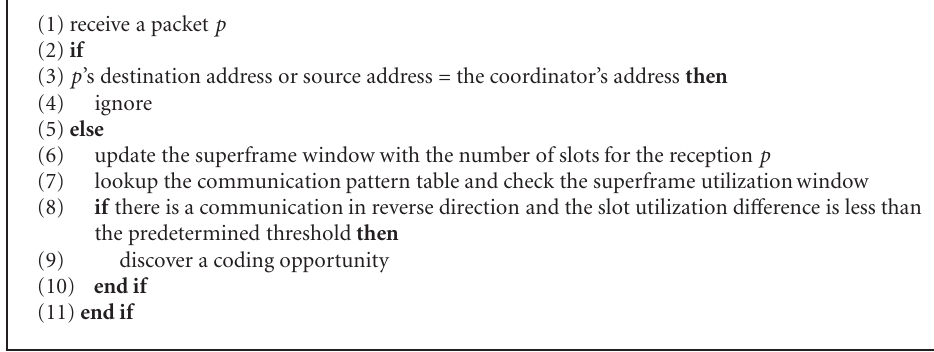
Algorithm 1: Algorithm to discover the intrasession network coding opportunities.